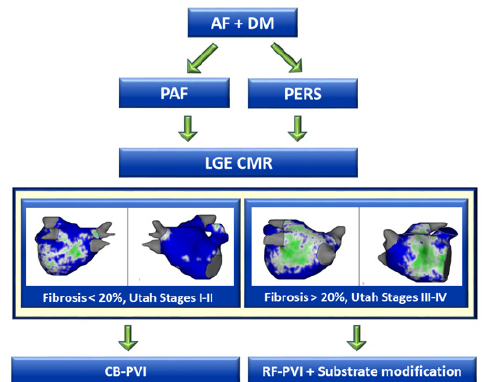
Figure 5. Proposed decision pathway for patients with DM scheduled for ablation due to AF. DM, diabetes mellitus, AF, atrial fibrillation, LGE CMR, Cardiac magnetic resonance imaging with late gadolinium enhancement; PAF, paroxysmal atrial fibrillation; cryoballoon-PVI, cryoballoon pulmonary vein isolation; RF-PVI, radiofrequency pulmonary vein isolation; PERS, persistent atrial fibrillation. All patients with DM and AF scheduled for an ablation procedure undergo LGE CMR in order to identify and categorize structural changes inside the left atrial wall irrespective of the diagnosis of PAF or